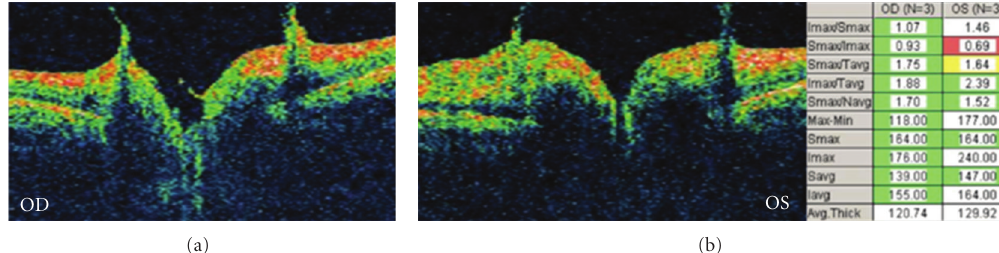
Figure 2: Optical coherence tomography of the right and left optic nerves demonstrating bilateral vitreopapillary traction.